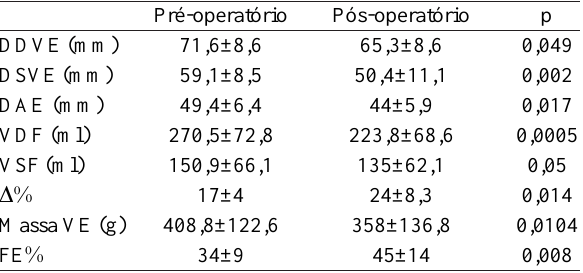
Fig. 2 - Ilustração esquemática da papilopexia cruzada